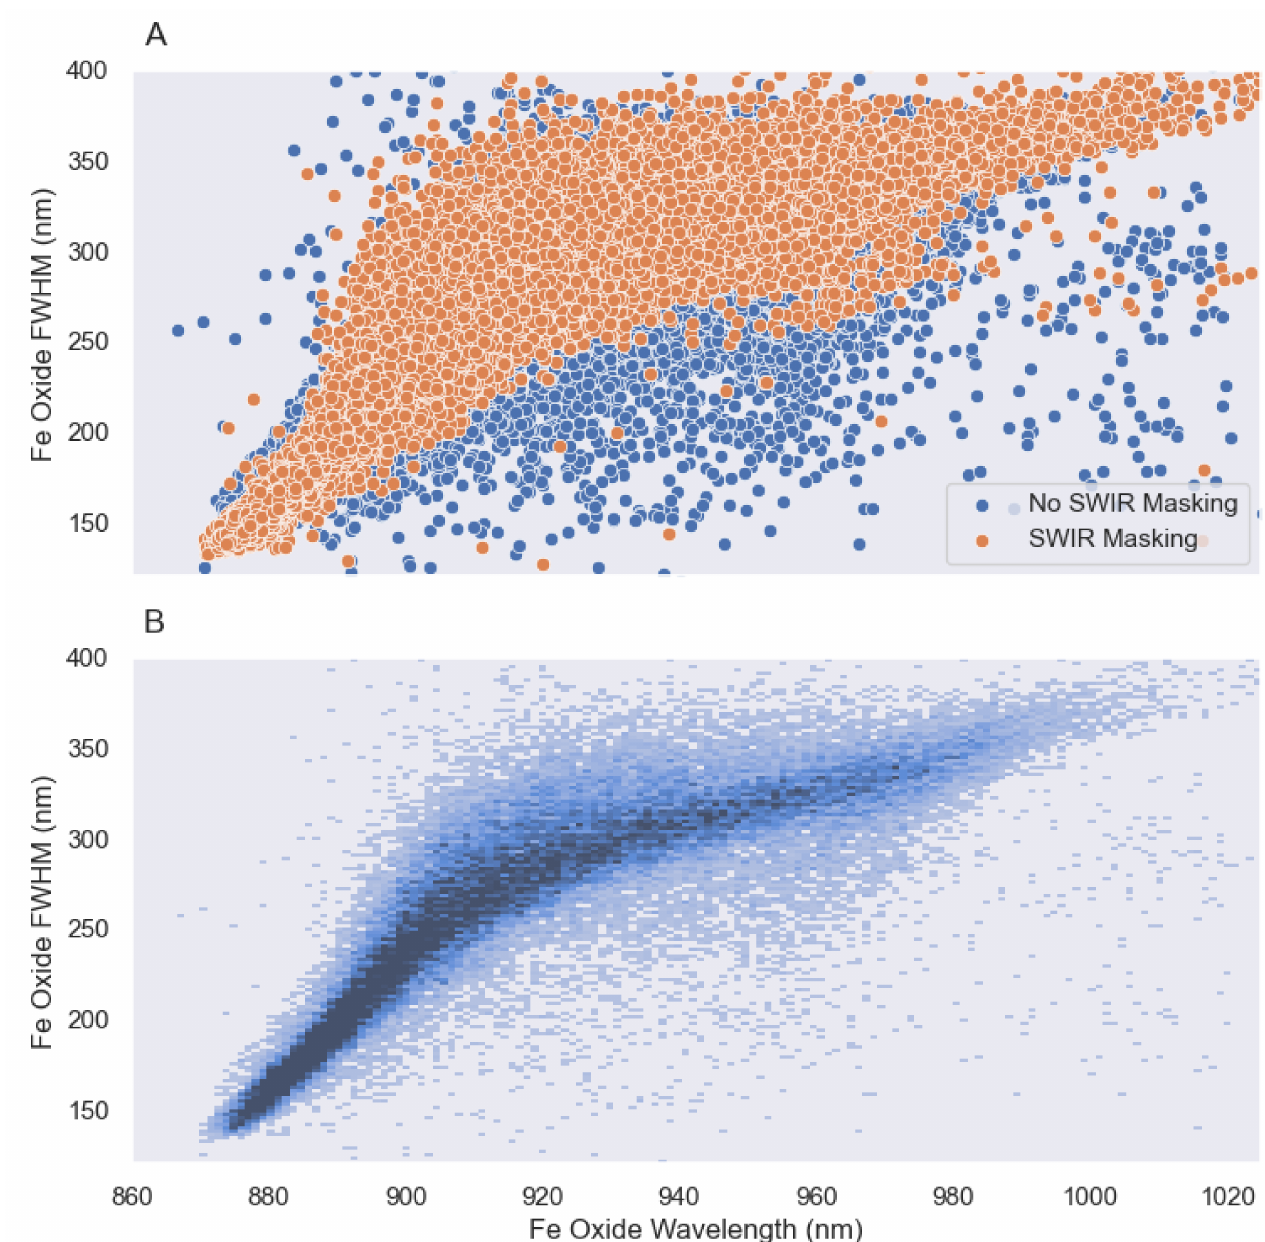
Figure 2. ( A ) shows the plot of the Fe oxide wavelength versus the Fe oxide FWHM for both the complete dataset (labelled as no SWIR masking) and the dataset after masking for SWIR alteration minerals (labelled as SWIR masking) which leads to a suppression of the Fe oxide FWHM values. ( B ) shows a density plot comprising 120 × 400 cells giving a spectral resolution of approximately 1.4 nm × 0.7 nm and demonstrates a typical density distribution of the iron boomerang for dense datasets. ( B ) is applied to the “no SWIR masking” data in ( A